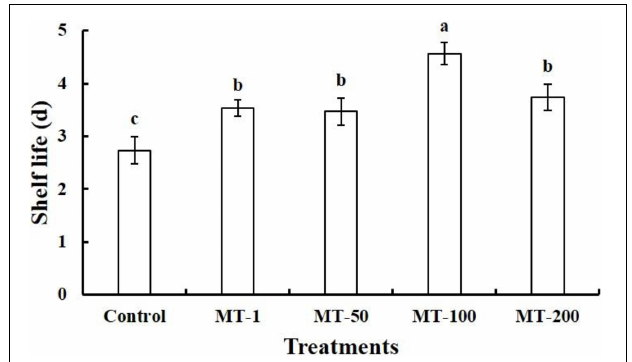
FIGURE 1 | Shelf life of different concentrations of melatonin-treated lateral buds of baby mustard during storage at 20 ◦ C. Different letters in the figure indicate statistically significant differences among treatments ( P < 0.05). MT-1, 1 µ mol L − 1 melatonin treatment; MT-50, 50 µ mol L − 1 melatonin treatment; MT-100, 100 µ mol L − 1 melatonin treatment; and MT-200, 200 µ mol L − 1 melatonin